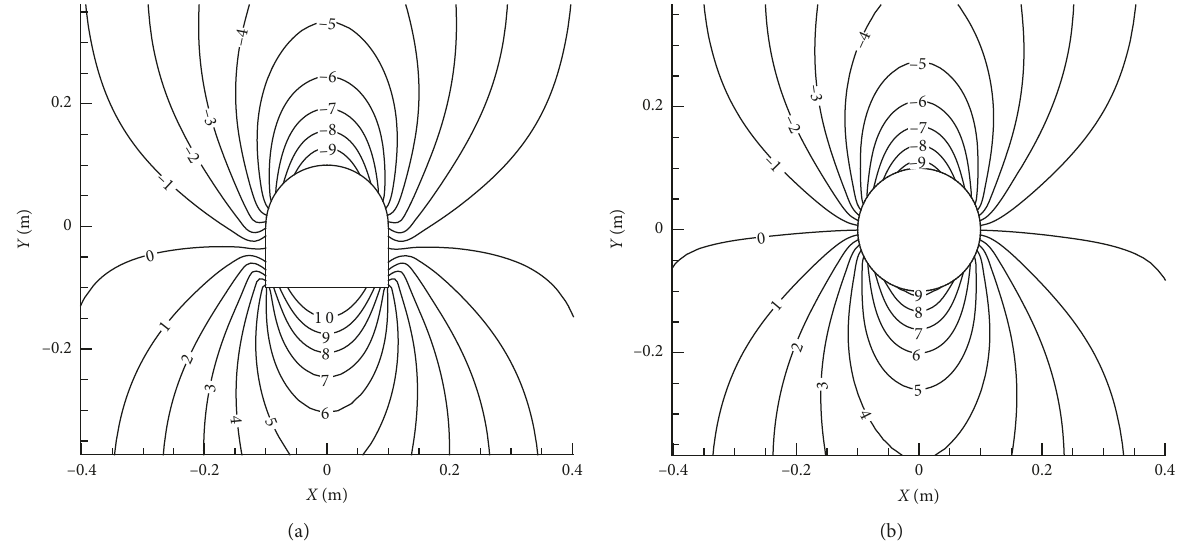
Figure 17: Numerical simulation results of the circumferential displacement in the rock surrounding the deep tunnel. (a) The horseshoe tunnel. (b) The circular tunnel.